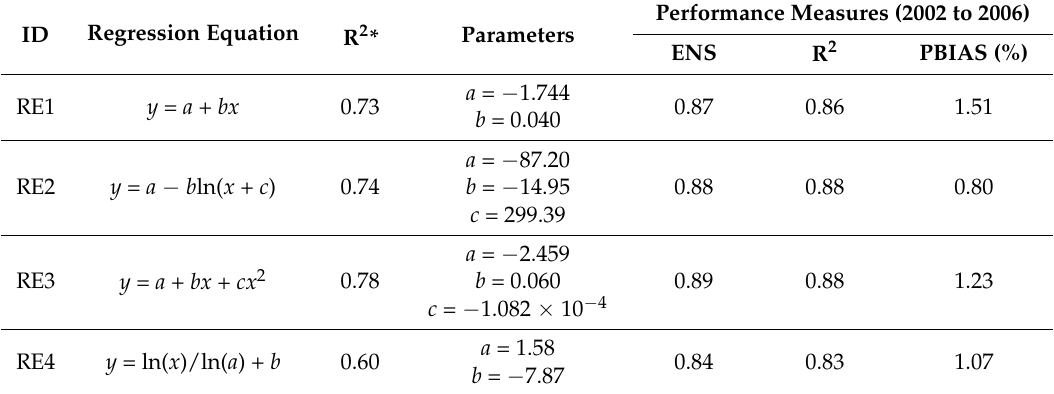
Table 2. Regression equations that describe the relation between additive component and rainfall intensify (daily rainfall depth) and their performances.